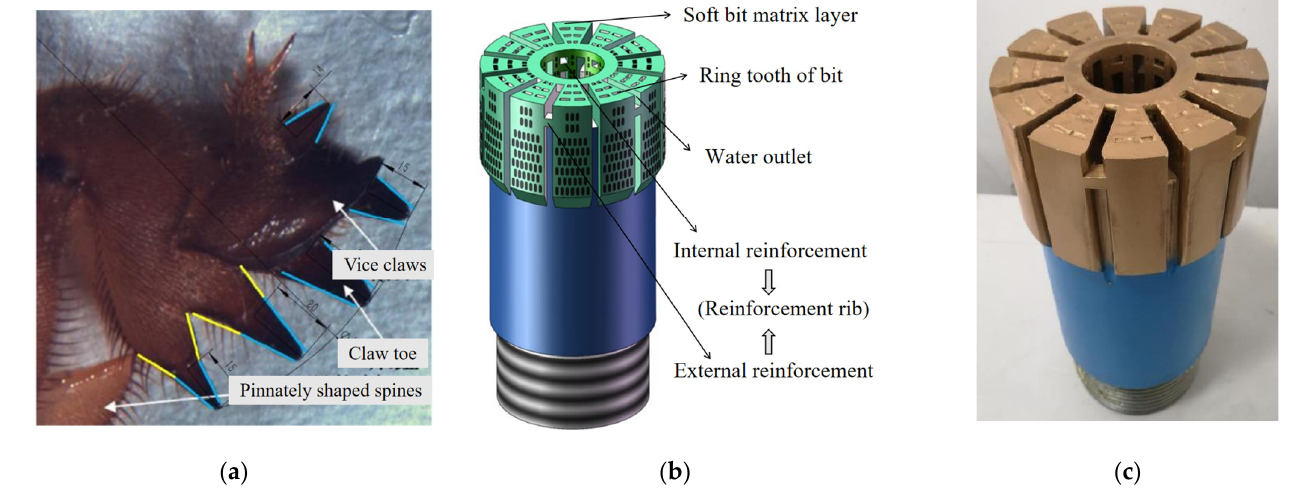
Figure 10. ( a ) The claw toe of mole cricket as the prototype bionic; ( b , c ) The appearance design of bionic core bit (scale 1:10).